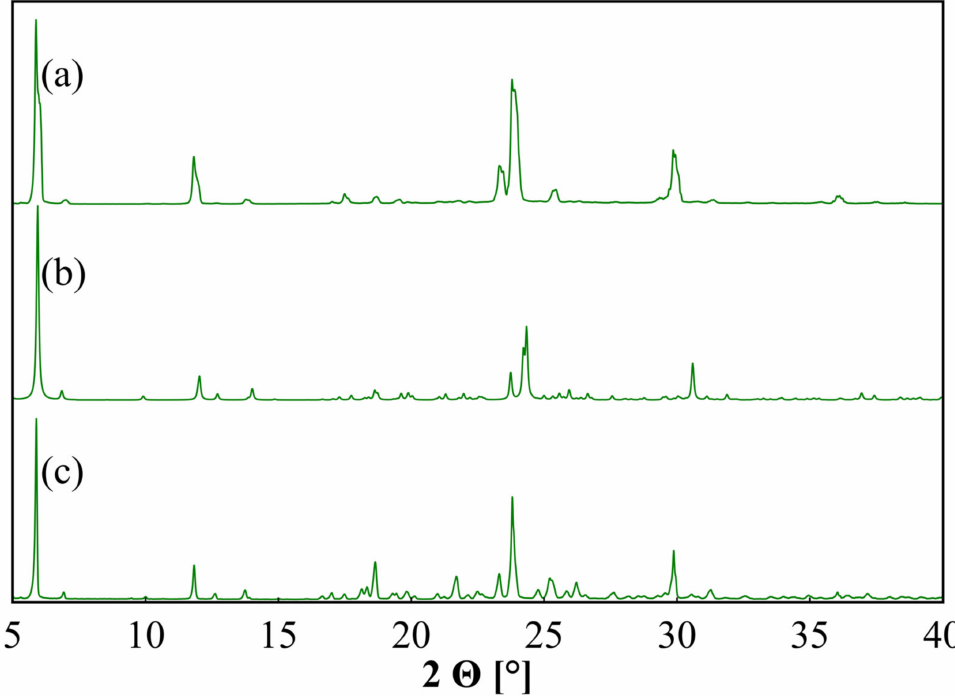
Figure 7. Powder patterns of ( S )-3 based maleates. Sample of ( S )-3-MA • H 2 O obtained by solution crystallization ( a ), simulated pattern based on single crystal data ( b ), and a sample of ( S )-3-MA • H 2 O obtained by mechanochemical crystal synthesis ( c ). Powder patterns were recorded in a range of 5 ◦ –40 ◦ 2 Θ